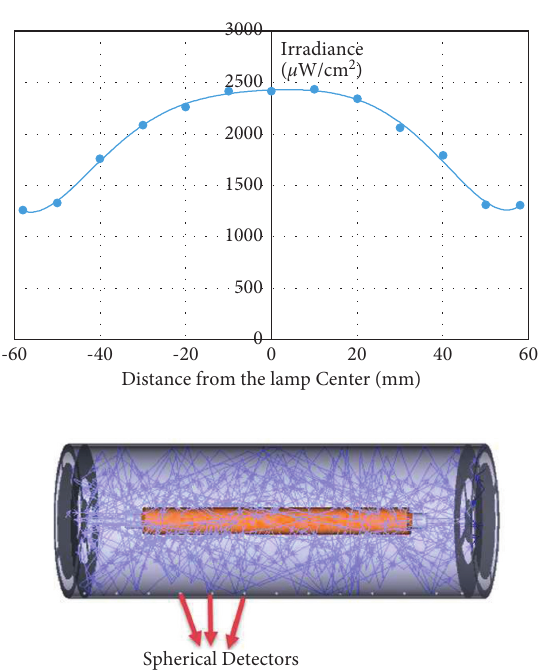
Figure 8: Average irradiance measurements with a spherical de- tector through the